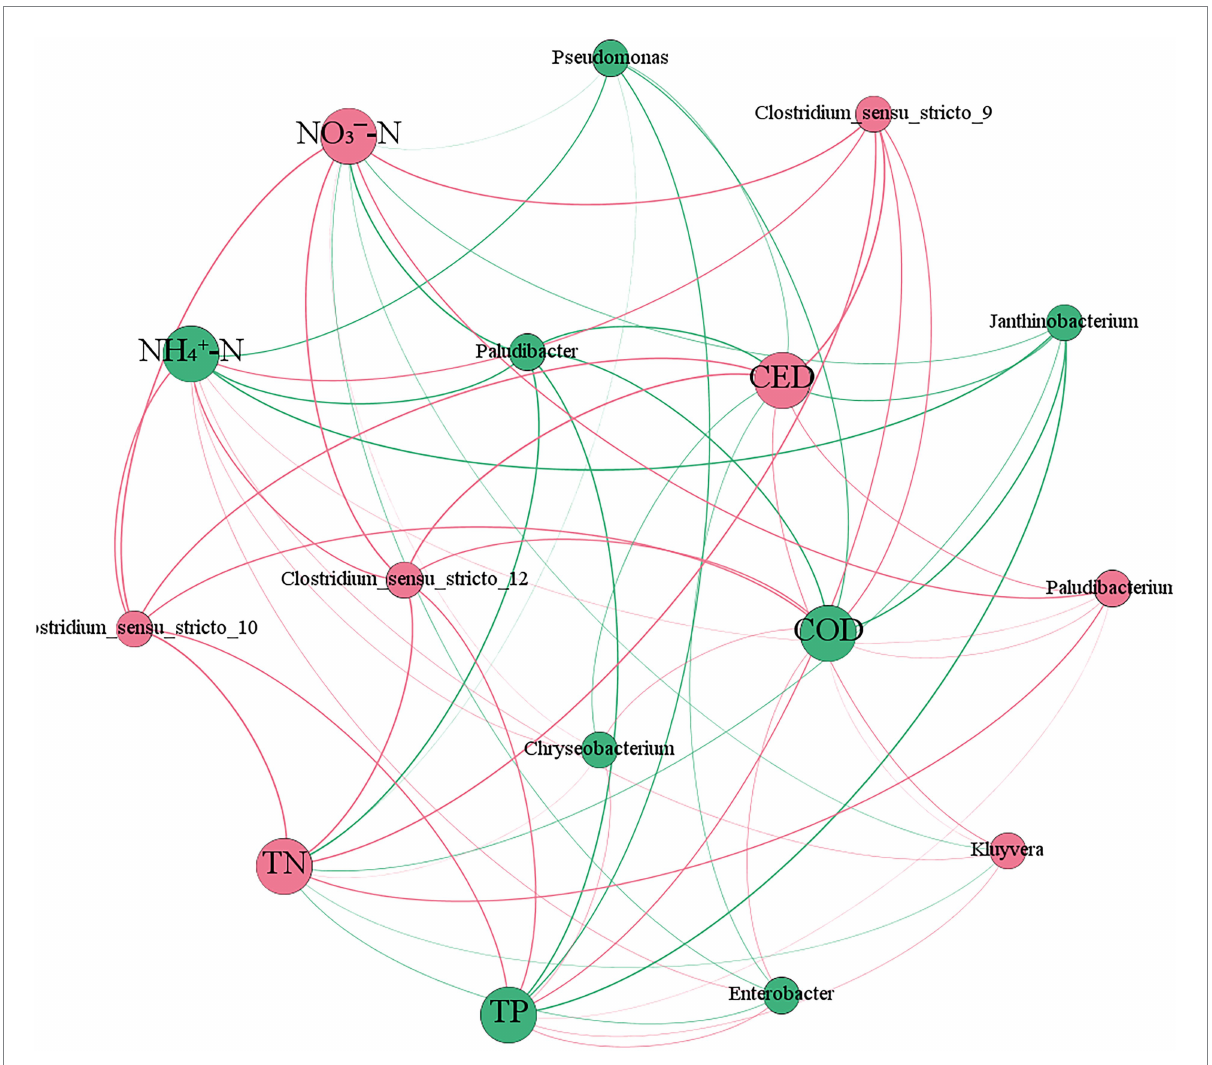
FIGURE 7 Network analysis plot of microbial dominant genus relative abundance and pollutants